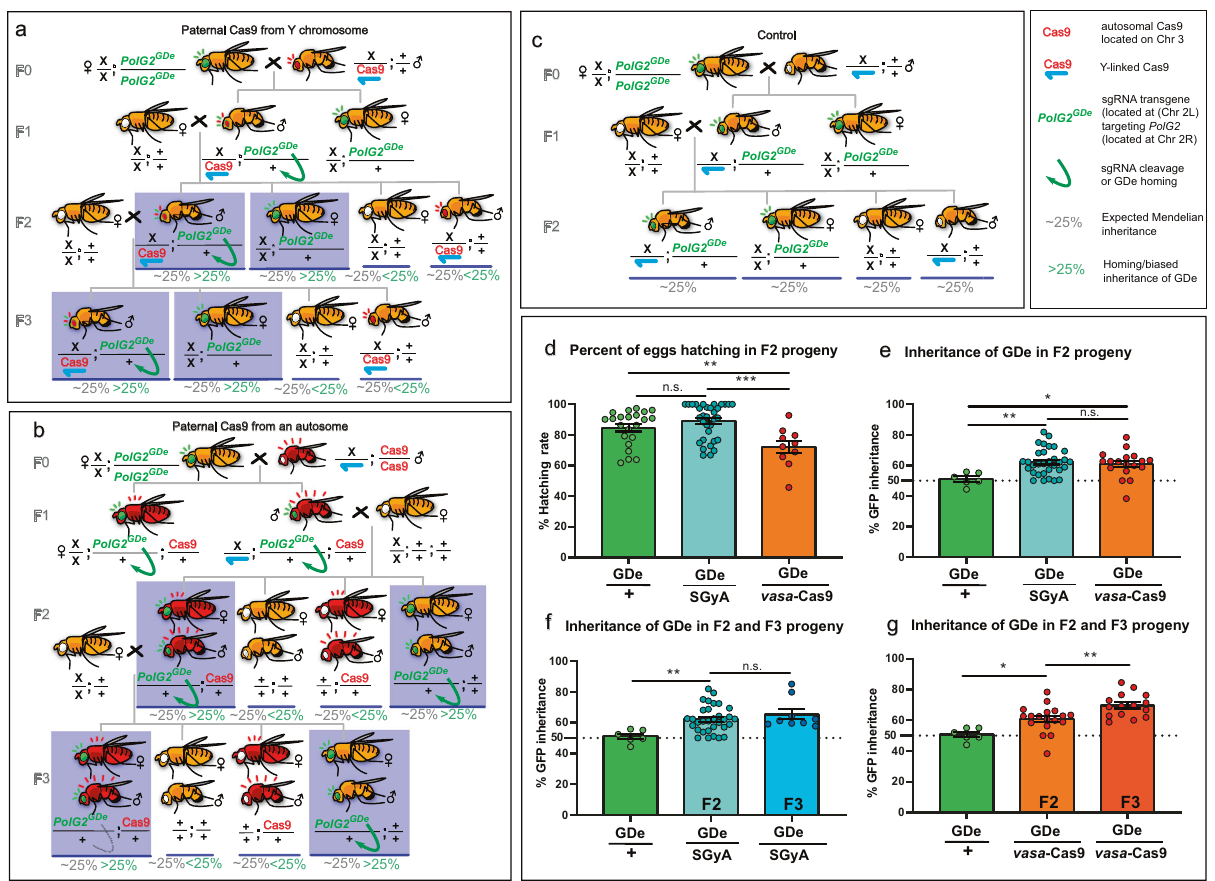
Fig. 4 Functionality of SGyA as a split gene drive using a re-coded GDe. a The crossing schematic involves the paternal Cas9 from the Y chromosome. The Cas9 transgene is only passed through the male germline. A SGyA male is crossed to homozygous GDe females to produce transheterozygous males and GDe-only females. The F1 transheterozygous male is then outcrossed to a w- females to assess GDe inheritance in F2 progeny. b The crossing schematic involves the paternal Cas9 from an autosome. A homozygous male harboring Cas9 on an autosome is outcrossed to a homozygous GDe female. Transheterozygous F1 males are subsequently outcrossed to w- females to assess GDe inheritance. Both sexes are affected. c Crossing schematic of the negative control cross. d Percent of F2 eggs hatched in crosses involving the control, transheterozygous SGyA males and transheterozygous autosomal Cas9 males. e Inheritance of the GDe in F2 progeny among different sources of Cas9. f Inheritance of the GDe in F2 and F3 progeny from crosses involving a transheterozygote male containing the GDe and the SGyA transgene. No signi fi cant deviations between both the F2 and F3 data sets were found ( p value = 0.3446). g Inheritance of the GDe in F2 and F3 progeny from crosses involving a transheterozygote male containing the GDe and the autosomal inheritance between F2 and F3 progeny ( p value = 0.0051) Blue shaded boxes in crossing schematics highlight instances where a bias of GDe transmission is observed. Green arrows indicate the conversion of WT PolG2 allele into the GDe. Gray numbers represent the expected Mendelian inheritance percentages of the GDe. Green percentages indicate the homing/bias of GDe. At least 18 experimental/replicate crosses were set up per Cas9 experiment, and 6 for the control to determine F2 progeny outcomes. For F3 outcomes, at least nine experimental crosses were performed. Signi fi cance was determined using a two-tailed unpaired student ’ s t test. For inheritance and male bias plots, vertical bars represent SEM. n.s. represents Non-signi fi cant. *** p < 0.0005; ** p < 0.001; * p < 0.01. Source data is provided as a Source Data fi